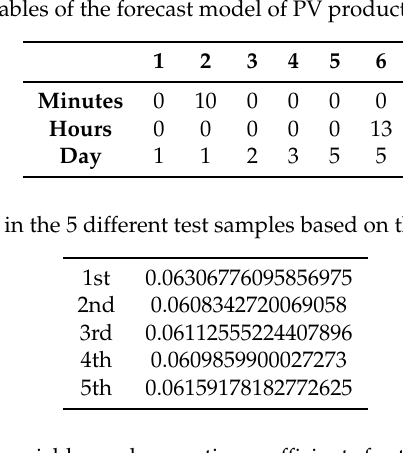
Table 6. Decision variables and respective coefficients for the model in Table